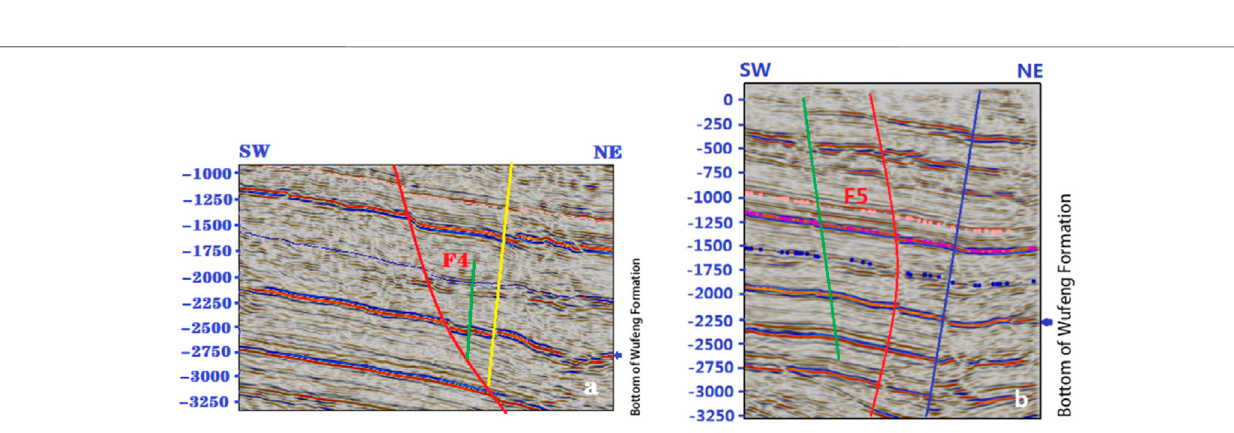
Frontiers in Earth Science |